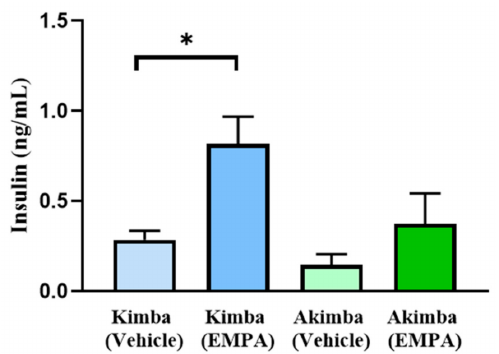
Figure 4. SGLT2 inhibition with EMPA increases circulating insulin levels in both Kimba and Akimba mice. Data represented as mean + SEM, n = 5–6 mice/group (Kimba), n = 3 mice/group (Akimba), using One-way ANOVA * p < 0.01 (Kimba Vehicle vs. Kimba EMPA). EMPA: Empagliflozin.